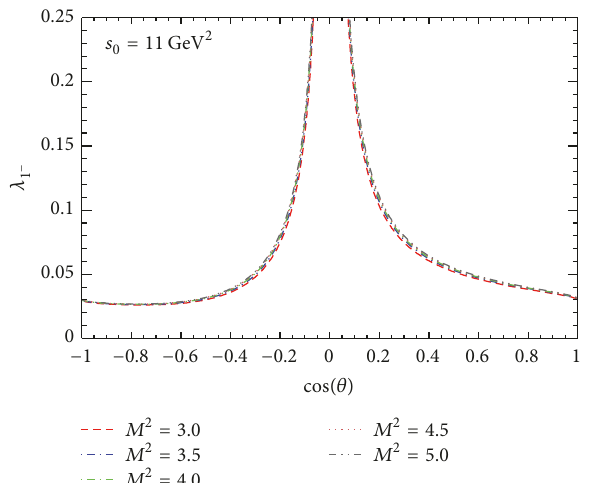
Figure 5: The dependence of strong coupling constant for Ω (3066) → Ξ 𝐾 on cos 𝜃 at 𝑠 = 11 GeV 2 and at three fixed values 𝑐 𝑐 0 of 𝑀 2 for scenario (a).